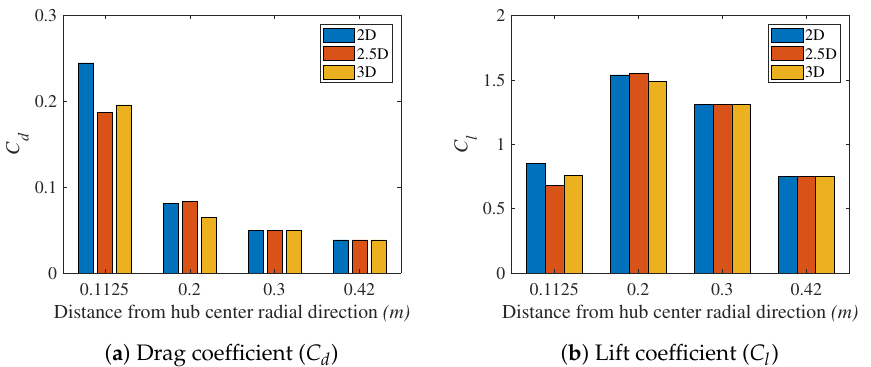
Figure 7. HAWT-S826: Illustration of ( a ) drag and ( b ) lift coefficient over the radial direction from the center for 2D, 2.5 and 3D geometric approximations.